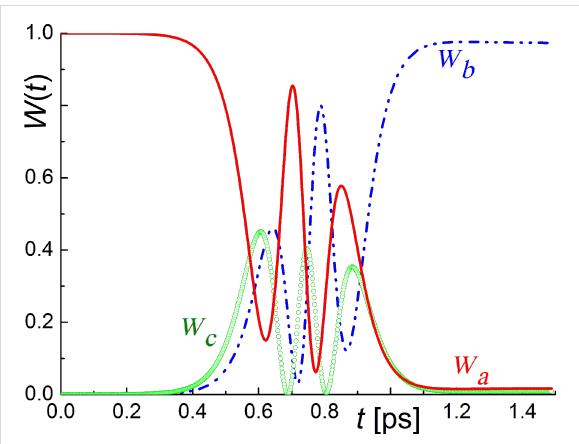
Figure 7: The dynamics of the ground level population, W a , and the populations of the two lowest excited levels, W b and W c , of the flux qubit system (µ 12 = 10 6 µ 0 , , ω 12 ≈ 10 10 Hz, ω 13 ≈ 3 ω 12 , a 0 = 1, b 0 = c 0 = 0) for the supercon- ducting qubit interacting with the passing fluxon (duration of external impact is about 1